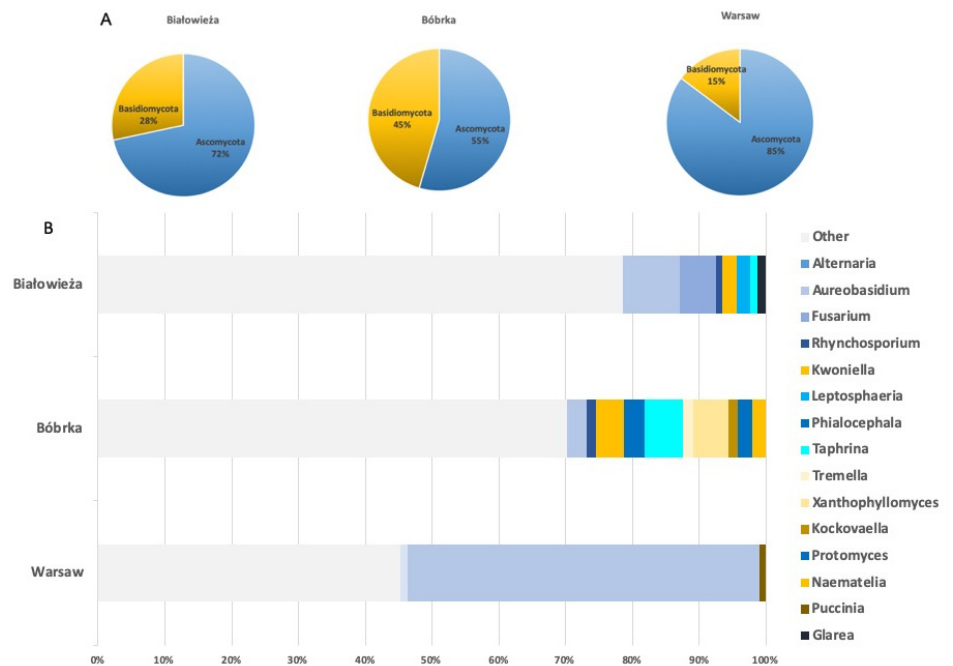
Figure 2. Total epiphytic fungal communities at the three locations according to shotgun metagenomic analyses. ( A ) Relative abundances for Ascomycota and Basidiomycota in the phyllosphere of the National Park of Białowie˙za, the crude-oil-polluted site of B ó brka, and the city center of Warsaw. ( B ) Relative abundances of classified fungal genera, with a cut-off value of ≥ 1.0%. Figure 2B. A cut-off value of 1.0% was set, and all genera having an abundance greater